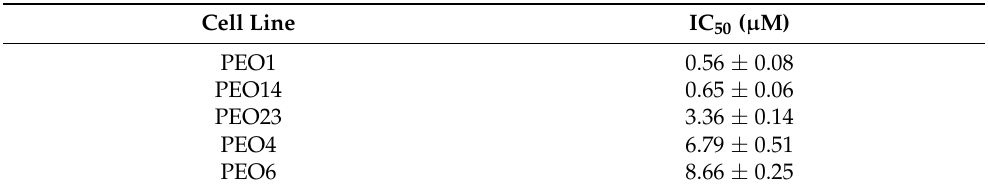
Table 1. Concentration of cisplatin needed to achieve 50% reduction in clonogenic survival (IC 50 ) of the HGSOC cell lines